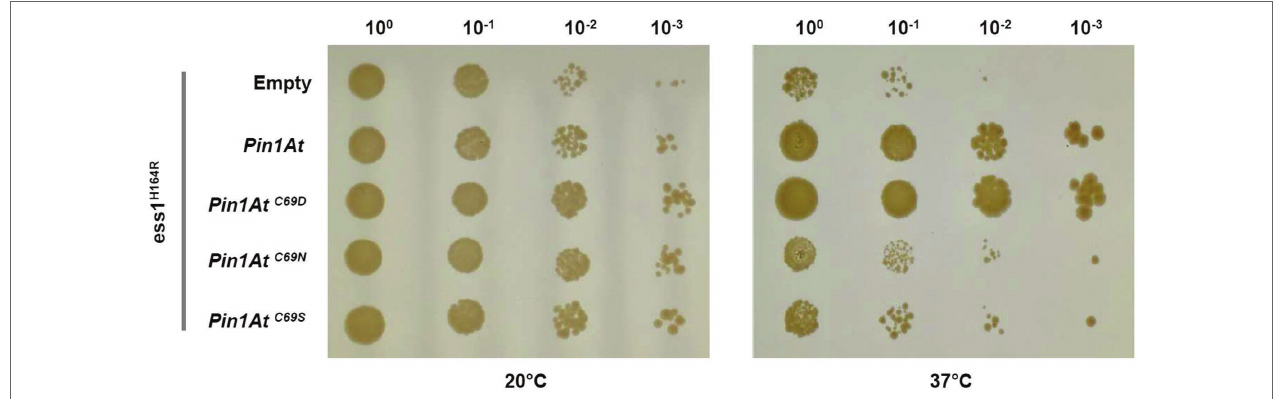
FIGURE 2 | Functional complementation of ess1 H164R strain by PIN1At and its variants. Cells expressing PIN1At and its C69D, C69N, and C69S variants (as assessed by RT-PCRs, Supplementary Figure S2 ) were plated as tenfold serial dilutions on SD - Ura medium. Functional complementation is visualized by the ability of transformed cells to grow at restrictive temperature (37 ° C) for 4 days. A control assay shows cells grown for 8 days at permissive temperature (20 ° C). The results shown here are representative of three independent experiments.